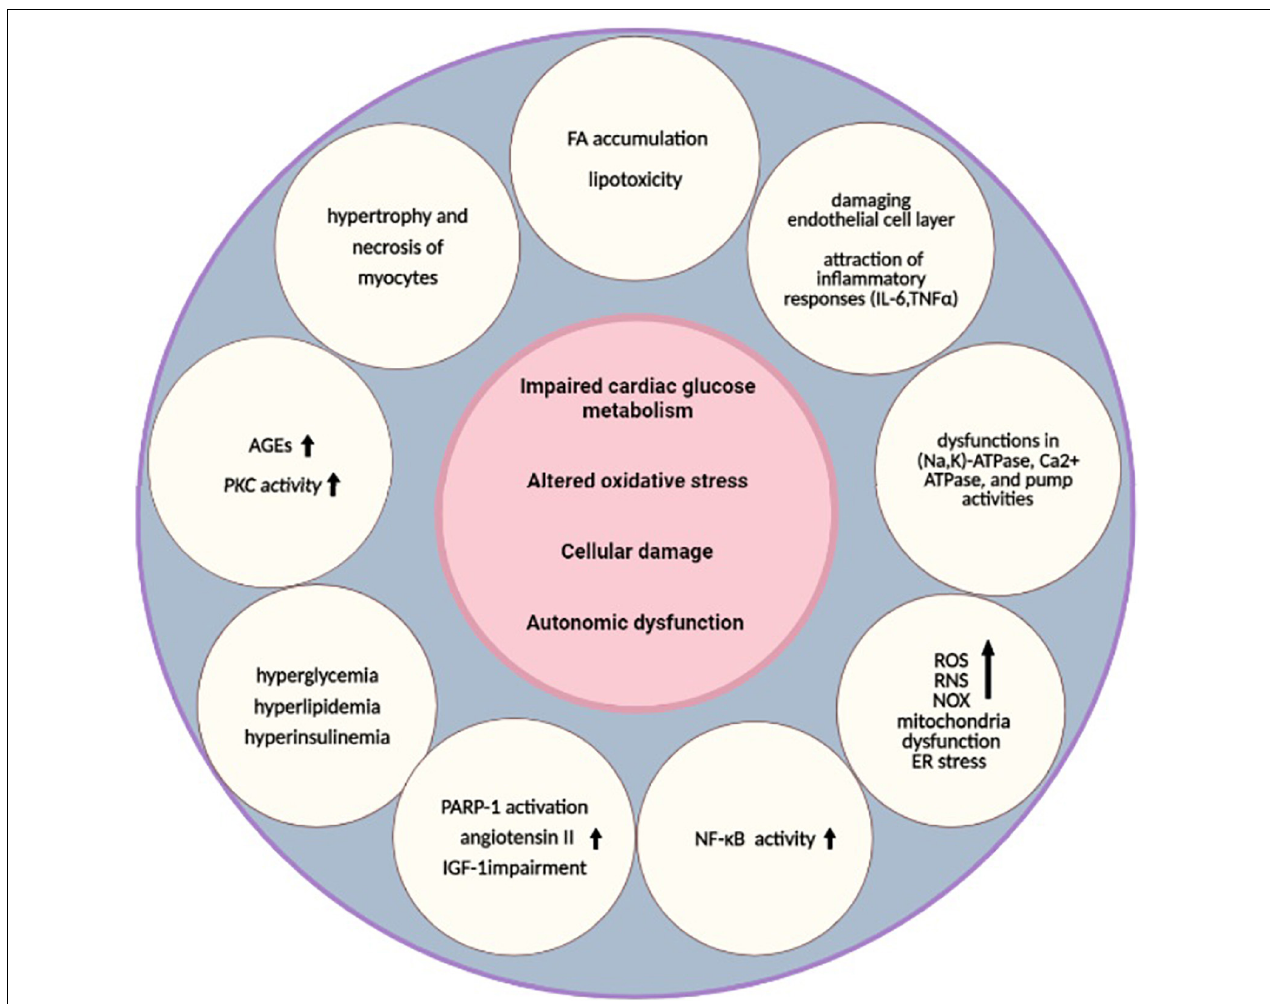
FIGURE 1 | Underlying pathways of diabetic cardiomyopathy. Impaired cardiac glucose metabolism (Mortuza and Chakrabarti, 2014), altered oxidative stress (Khullar et al., 2010), cellular damage (Cai and Kang, 2003), and autonomic dysfunction are the main pathological mechanisms that are common between T2DM and HF (Rodriguez-Saldana, 2019). Several other alterations, such as hyperglycemia, hyperlipidemia, hyperinsulinemia (Borghetti et al., 2018), higher AGEs, increased PKC activity (Brahma et al., 2017; Kaludercic and Di Lisa, 2020), FA accumulation, lipotoxicity (Maisch et al., 2011), damaged endothelial cell layer, attraction of inflammatory responses (IL-6, TNF α ) (Lorenzo et al., 2011), higher NF- κ B activity (Faria and Persaud, 2017), dysfunctions in (Na,K)-ATPase, Ca2+ ATPase, and pump activities, depressed CK activities (Cai and Kang, 2001), increased levels of ROS, RNS, NOX (Liu et al., 2014), mitochondria dysfunction